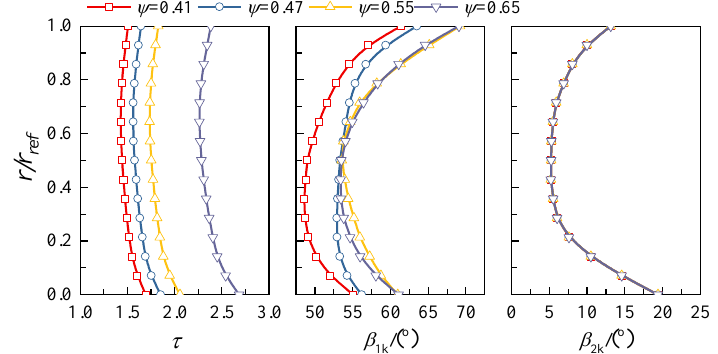
Figure 10. Comparison of design parameters for the four compressor stages: stator.